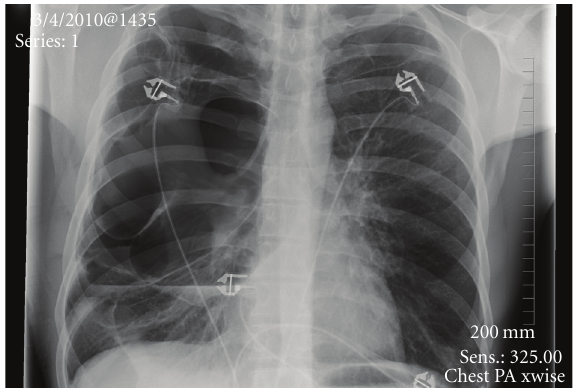
Figure 1: Chest X ray showing bullous disease.